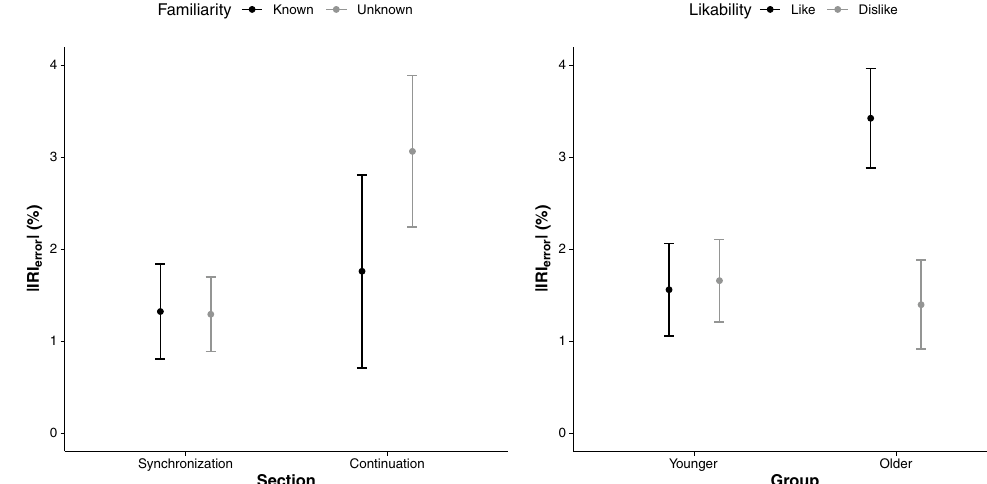
Figure 9. Effects of song preferences and familiarity on motor timing. Mean |IRI error | in % for each section (synchronization, continuation) as a function of familiarity (known, unknown) [left panel]. Mean |IRI error | in % for each group (young, older) as a function of likability (like, dislike) [right panel]. 95% CIs are represented in the figure by the error bars attached to each mean